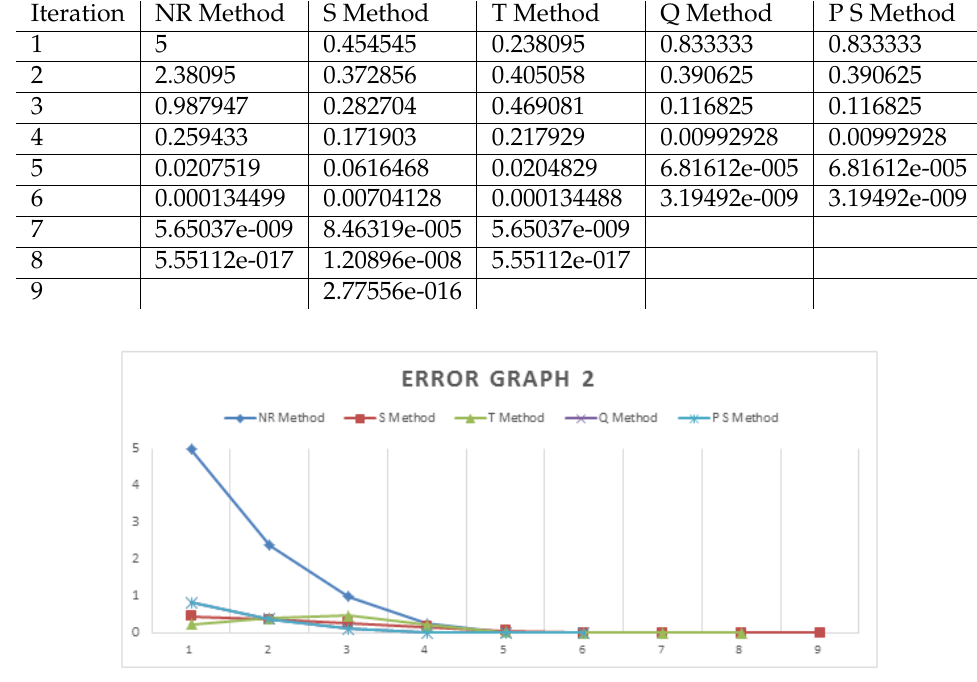
Figure 2. Graphical comparison of error analysis for the Equation (19)